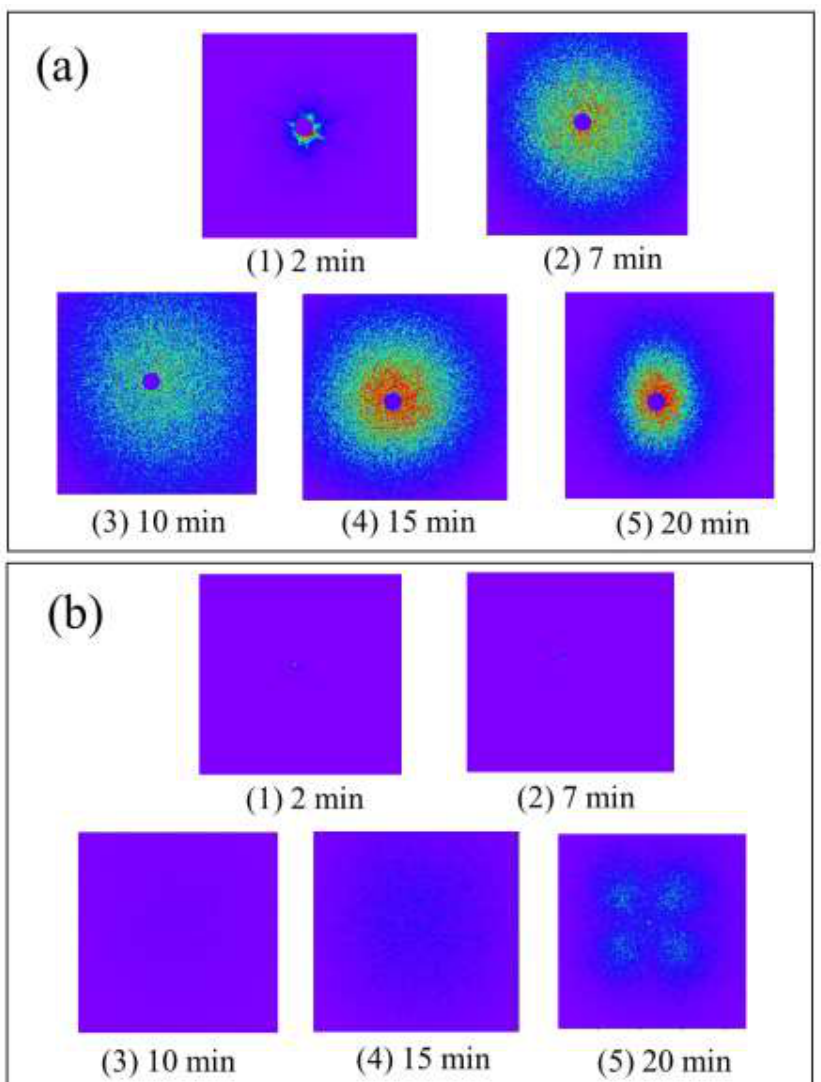
Figure 6. Series of light scattering image of γ -spherulite of PVDF/TBAHS during isothermal crystal- lization at 165 °C: ( a ) Vv scattering; ( b ) Hv scattering.